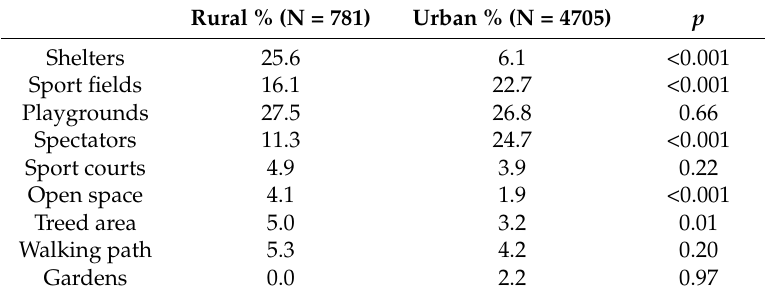
Table 4. Percentage of all visits observed at amenities in rural and urban parks a .